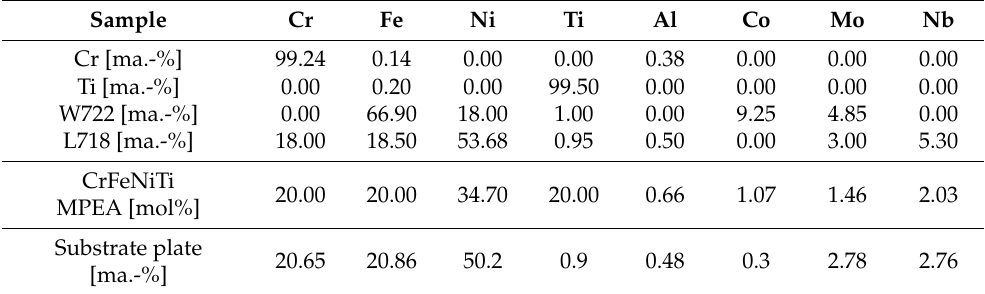
Table 1. Chemical composition of the input material powders (nominal), the mechanically alloyed CrFeNiTi MPEA (nominal), and the substrate plate (optical emission spectrometer).